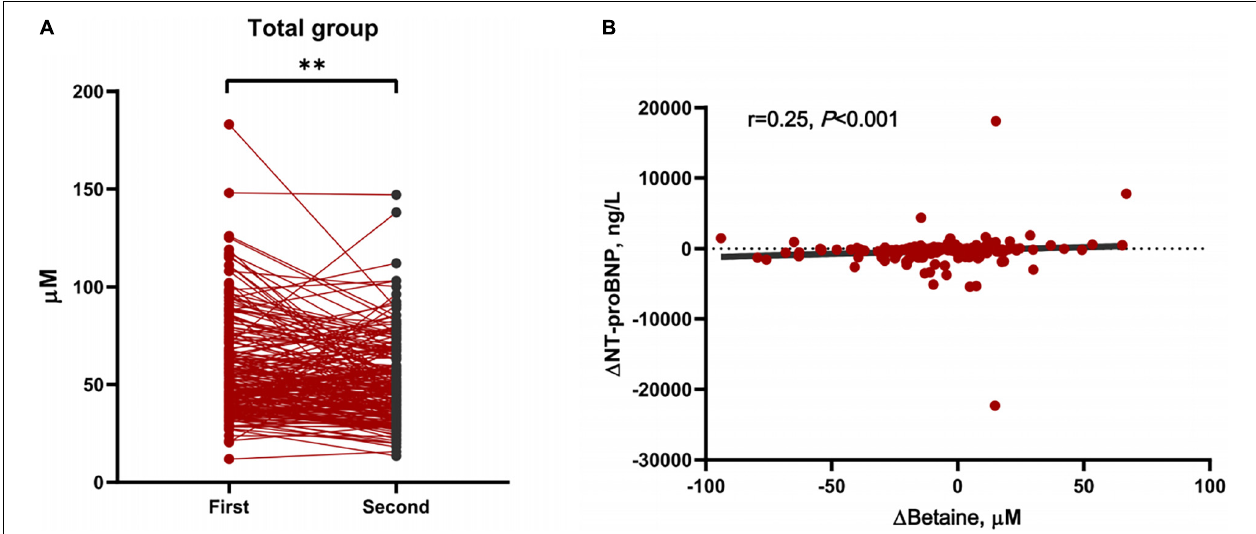
FIGURE 3 | Changes of betaine between first and second hospitalization and the association between (cid:49) betaine and (cid:49) N-terminal pro-brain natriuretic peptide (NT-proBNP). (A) Demonstration of plasma levels of betaine after further guideline-recommended treatment in all PH participants (n = 203). Data were compared using paired-samples t-tests. ** p < 0.001. (B) The positive association between (cid:49) betaine and (cid:49) NT-proBNP. (cid:49) betaine and (cid:49) NT-proBNP were defined as the value at the second admission visit minus the baseline value. Spearman’s correlation (2-tailed) was used for analysis.